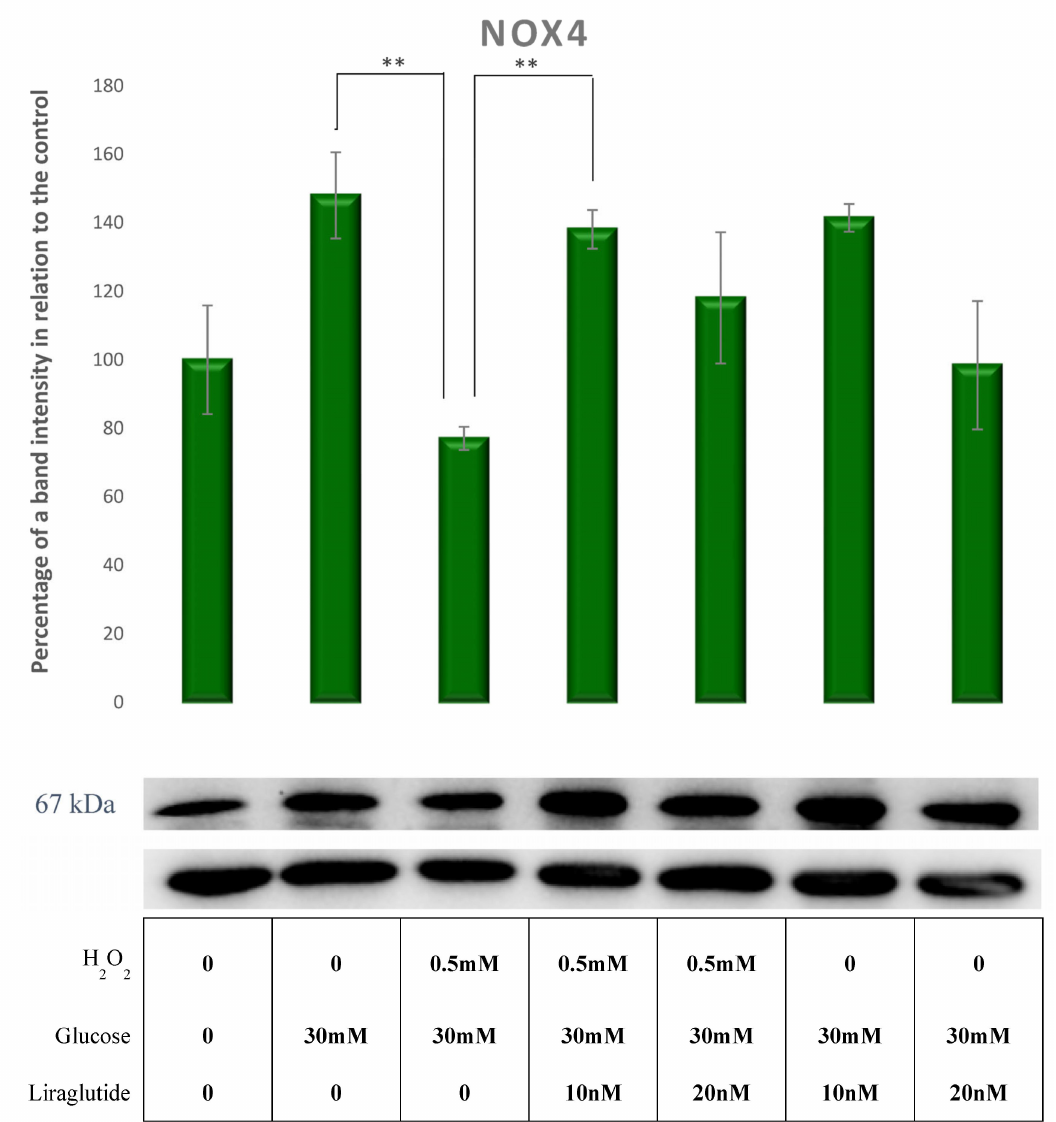
Figure 10. Protein expression in the LLC-PK1-treated cell line (control vs. HG30 and HG30/H 2 O 2 ; HG30 vs. HG30/Lira10 and HG30/Lira 20; HG30/H 2 O 2 vs. HG30/H 2 O 2 /Lira10 and HG30/H 2 O 2 /Lira 20) determined by Western blot. Glyceraldehyde 3-phosphate dehydrogenase (GAPDH) was used as an internal control. The data are shown as the means ± SD (standard deviation) from three independent biological replicates. One-way ANOVA F(6,20) = 4.154, p = 1.32 × 10 − 2 with Tukey HSD post hoc test; ** p < 0.01. Values underneath the x axis represent the amount of compound added in the experiment, and 0 represents that the compound was not added. Protein expression, pig proximal tubule cell line (LLC-PK1), HG (1.5 mM, 30 mM), H 2 O 2 (0.5 mM), Liraglutide (10 nM, 20 nM). iNOS levels remained unaffected by the treatment with HG30 and HG30/H 2 O 2 .